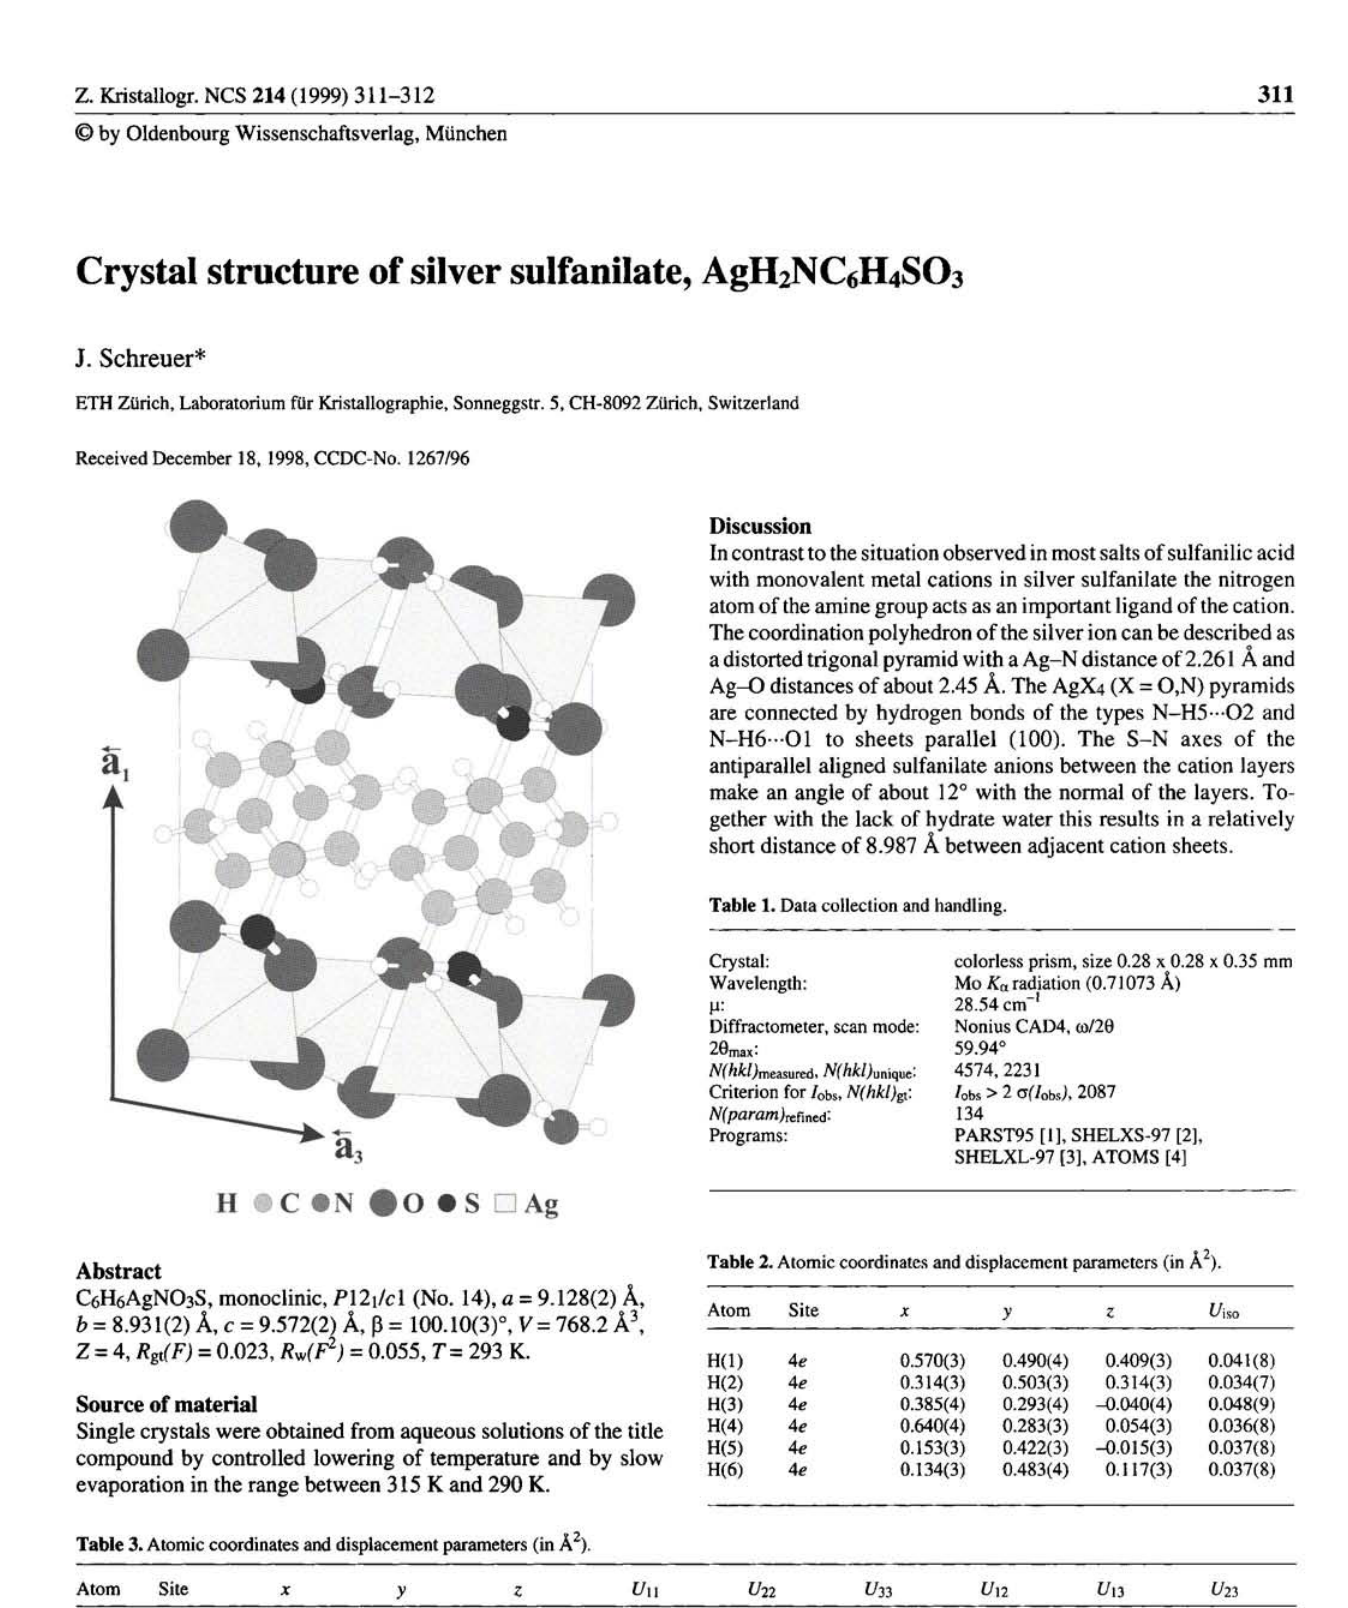
Table 3. Atomic coordinates and displacement parameters (in À 2 ).